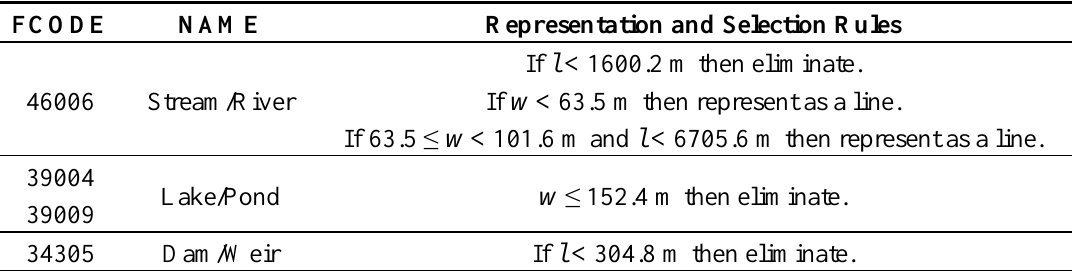
Table 1. Representation and selection rules of National Hydrography Dataset standards for the features shown in the study area.